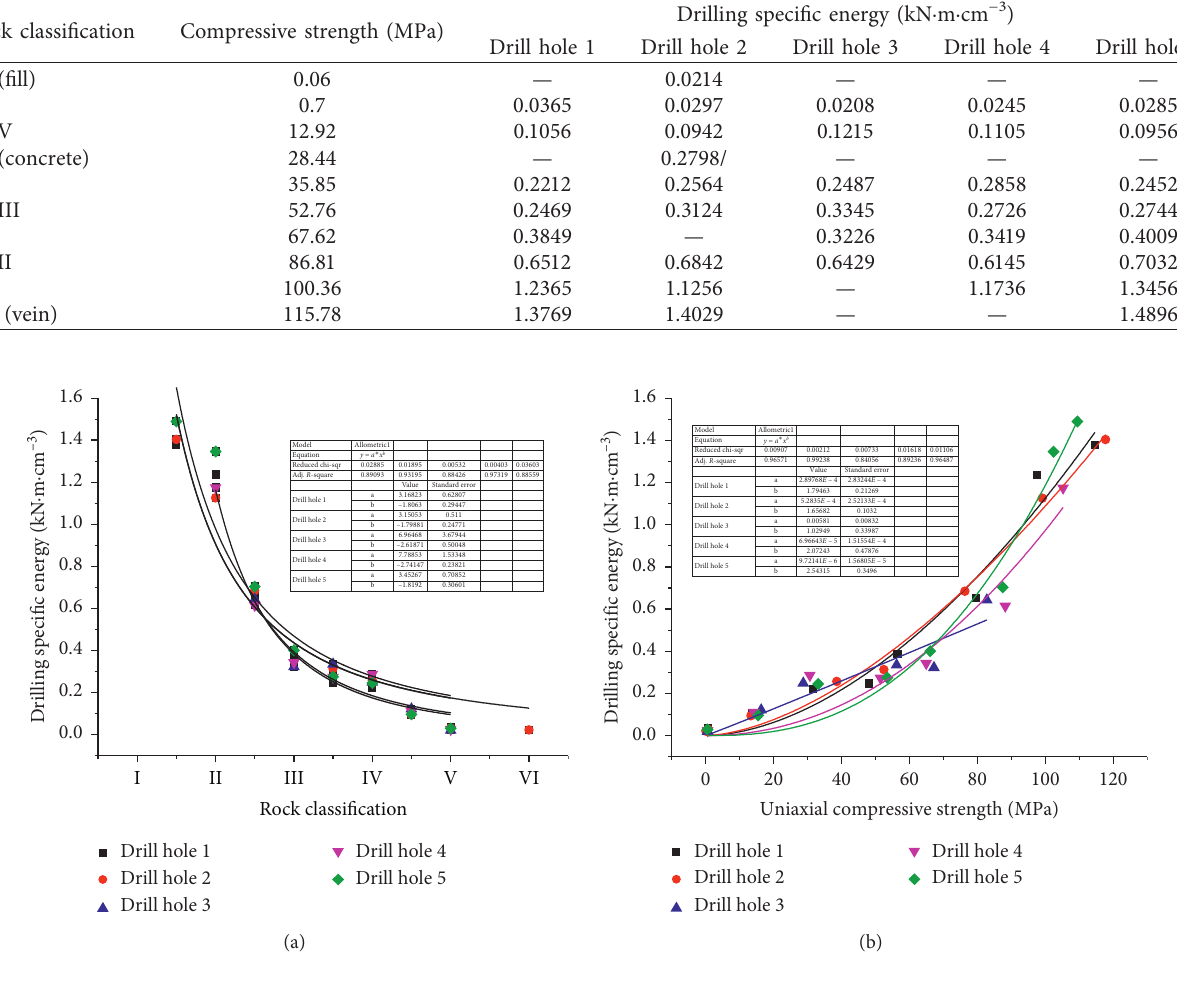
Table 14: Rock classification and compressive strength statistics based on drilling specific energy.